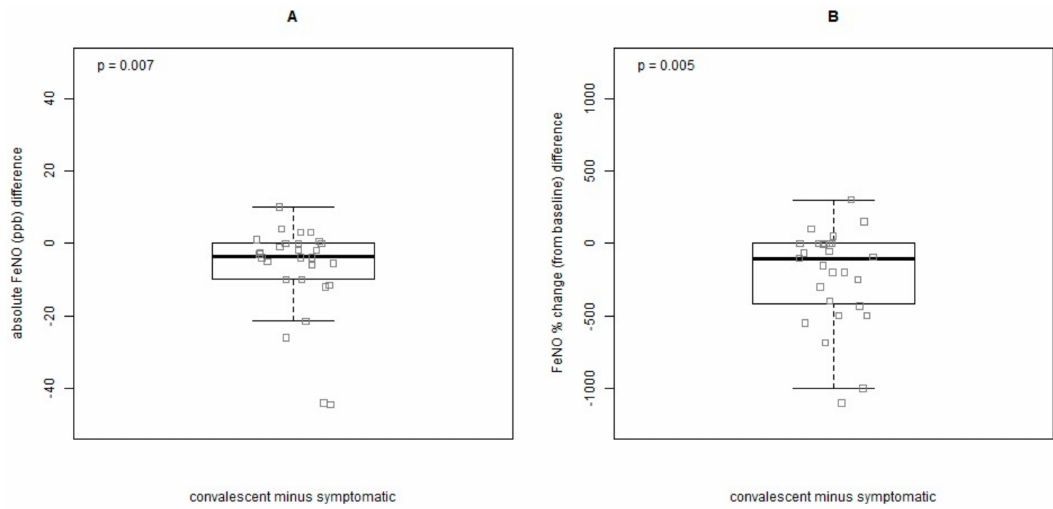
Figure 3. Di ff erence in FeNO values of preschoolers with asthma during exacerbations and at their respective convalescent visits ( A ) in absolute values, ( B ) in FeNO % change (from